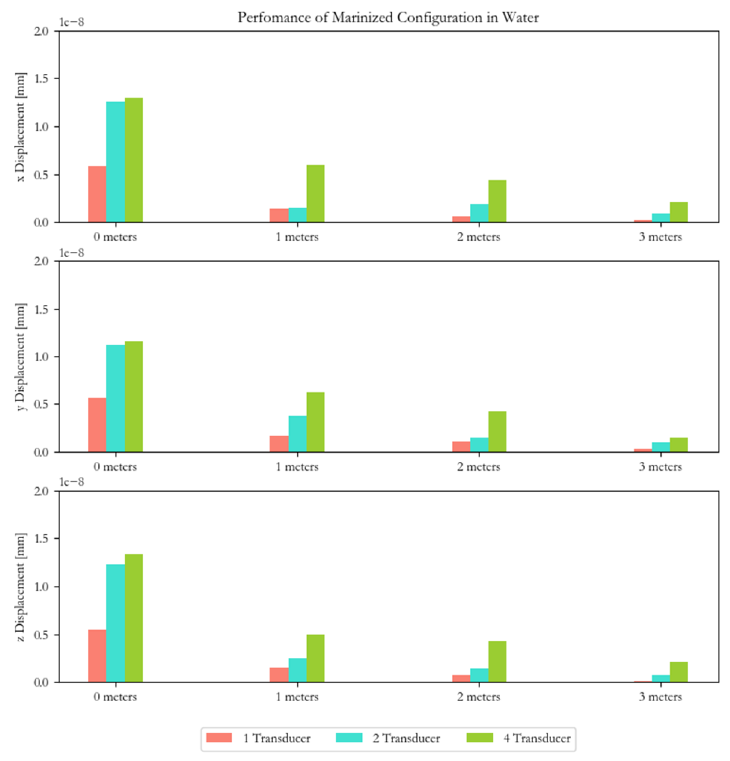
Figure 15. Performance of marinized configuration in water.